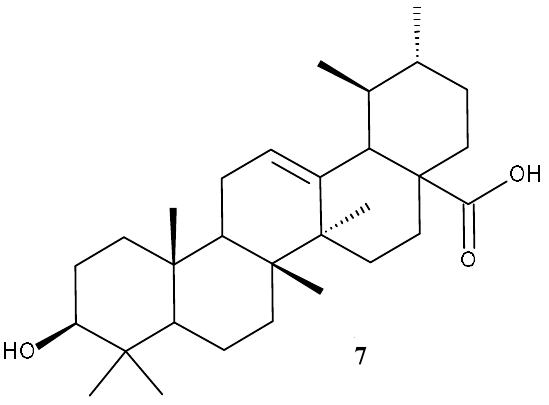
Figure 12. The chemical structure of ursolic acid ( 7 ).